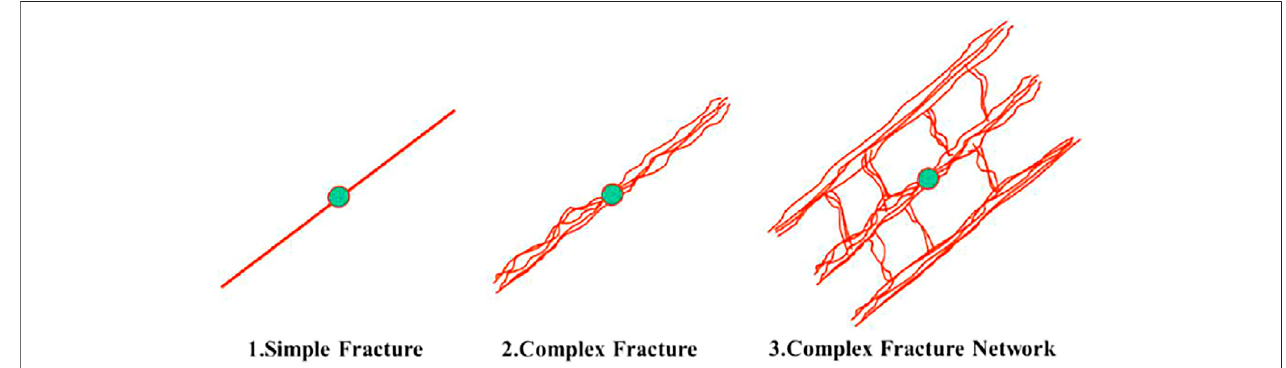
FIGURE 2 | Types of hydraulic